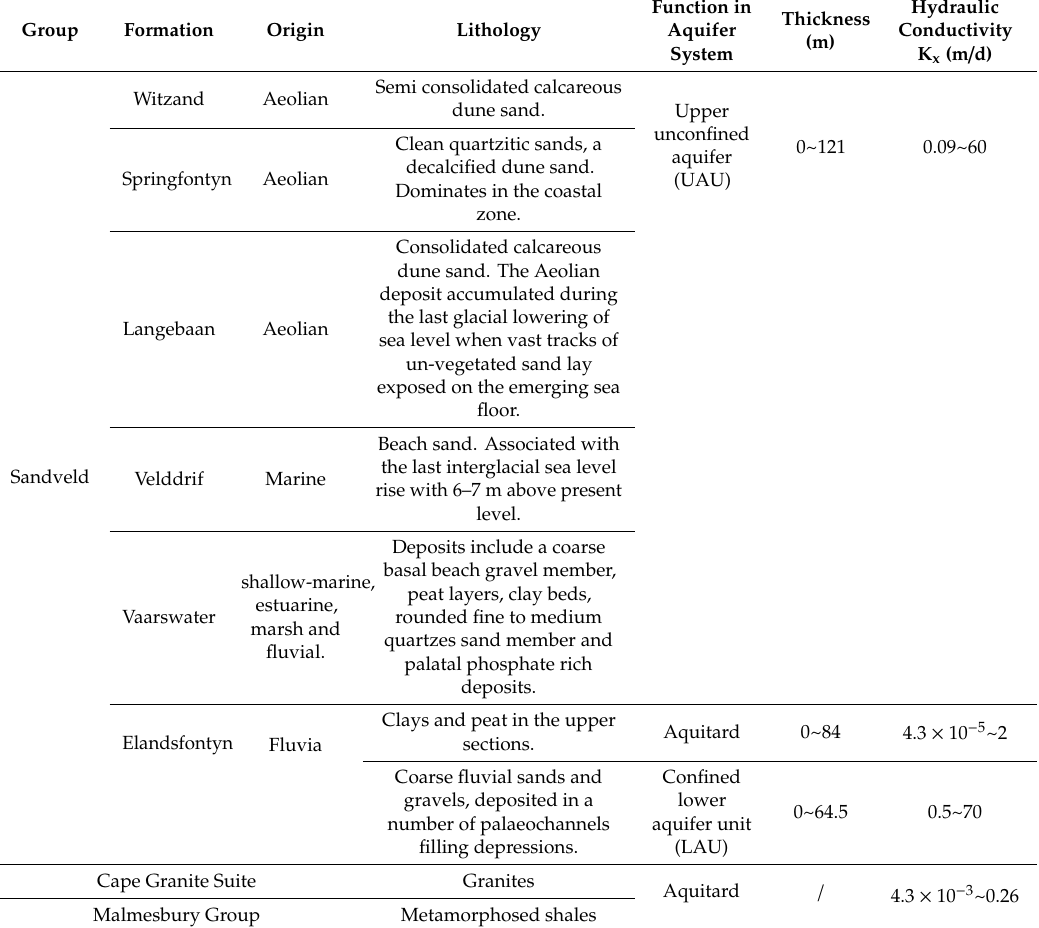
Table 2. Stratigraphy and hydrogeological characteristics of the West Coast (after Seyler et al. 2016 [26]; Roberts and Siegfried 2014